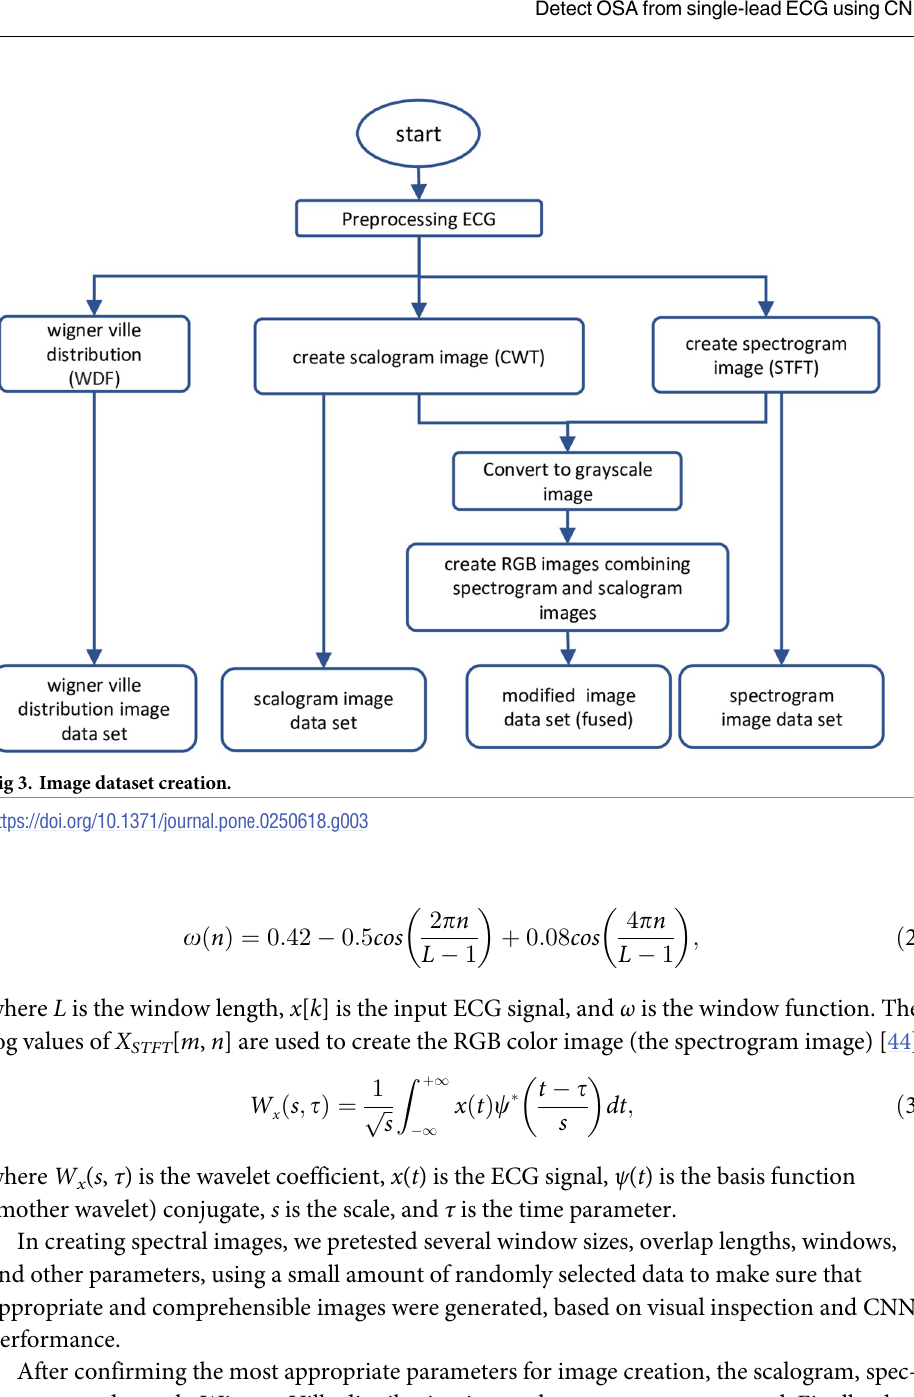
Fig 5. Fused images were created by embedding gray-scale values of the scalogram and its matching spectrogram into three layers of an RGB image. To embed the CWT and STFT rep- resentations into one image, the gray-scale values of the scalogram image were used as the “red” component of the new image, and the “green” component was formed using the corre- sponding gray-scale values of the spectrogram. The “blue” layer was created by the addition of the gray-scale values of the scalogram and spectrogram. In this way, the three RGB layers of the fused image accommodated picture elements from both scalogram and spectrogram